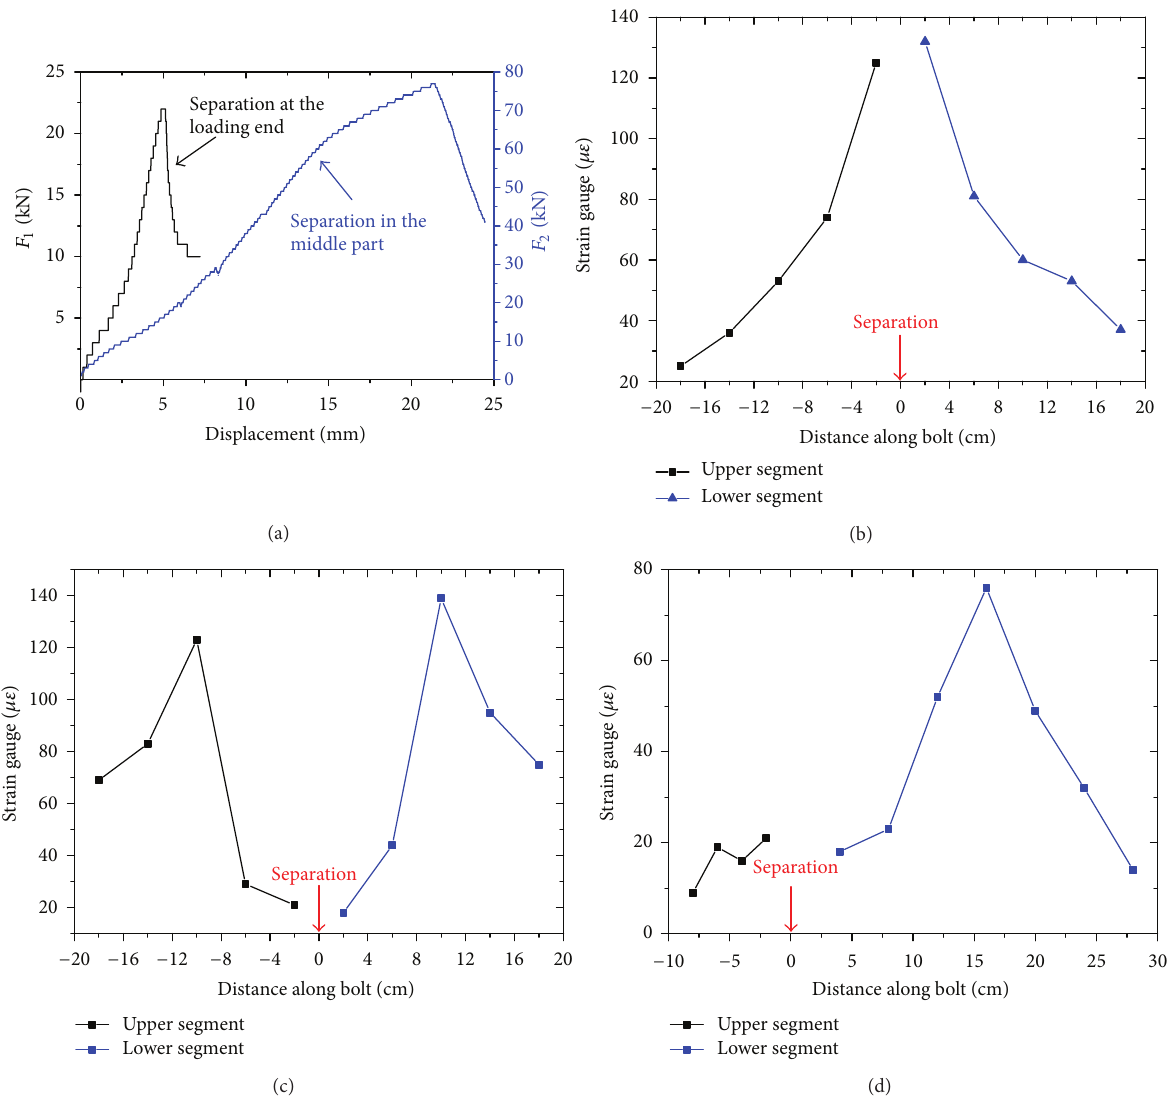
Figure 12: Experimental results for the anchoring body with separation at different locations. (a) Relationship between pulling force and pulling displacement. (b) Relationship between the strain and distance along the bolt when the interface is in its original intact state and the separation is located in the middle, (c) the interface is partly damaged and the separation is located in the middle, and (d) the interface is partly damaged and the separation is located at the loading